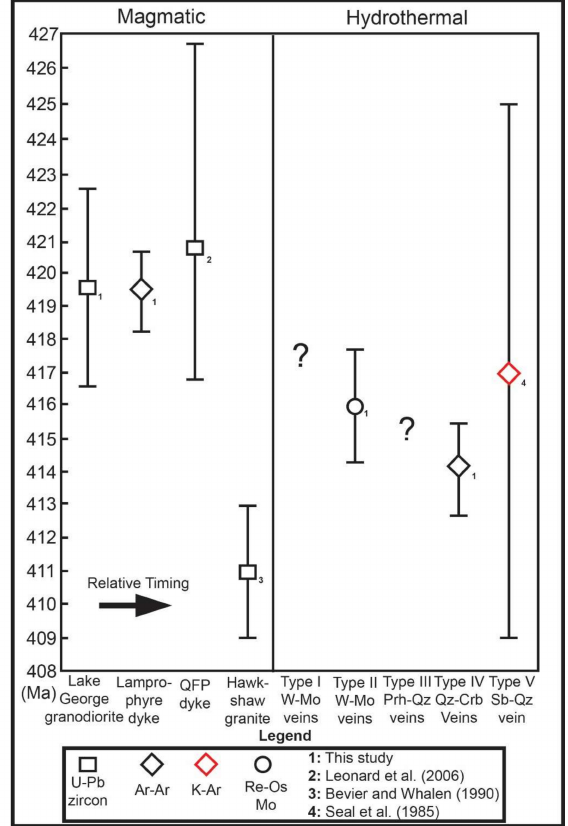
Figure 24. Schematic representation comparing the dates obtained from this study and others of the various magmatic–hydrothermal events at the Lake George mine. The events are ordered from left to right by previously identified cross-cutting relationships and labeled with the age of the most recent geochronological methods used to date them. The errors associated with the dates reported are all 2 σ